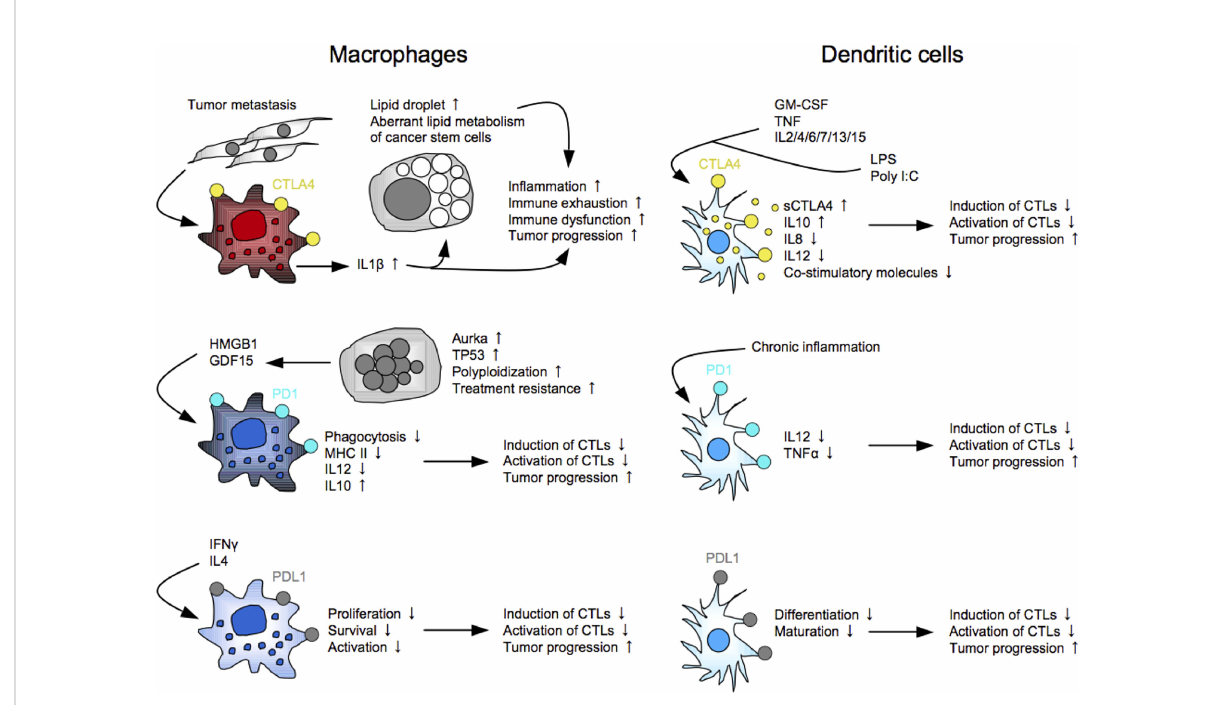
FIGURE 2 Myeloid subsets expressing immune checkpoint molecules. As well as PDL1, CTLA4 and PD1 are functionally expressed in myeloid cells, including macrophages and dendritic cells, and play key roles in induction of immune suppression and exhaustion in the